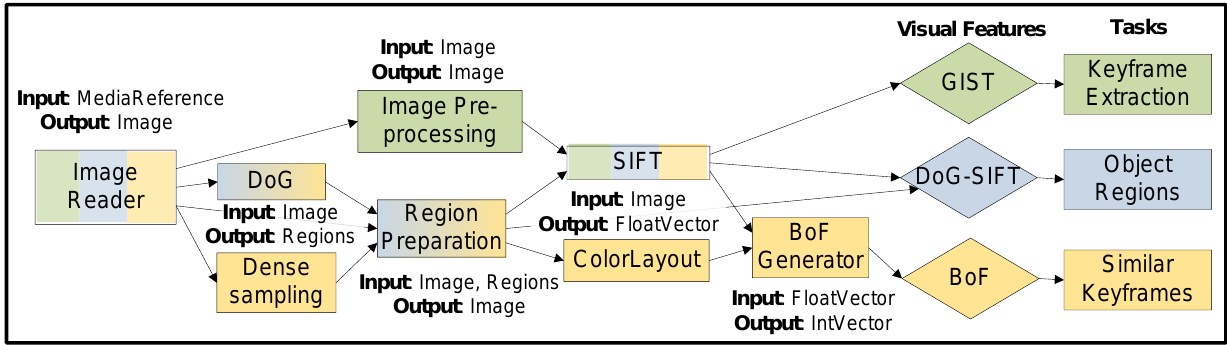
Figure 6. Visual feature extraction